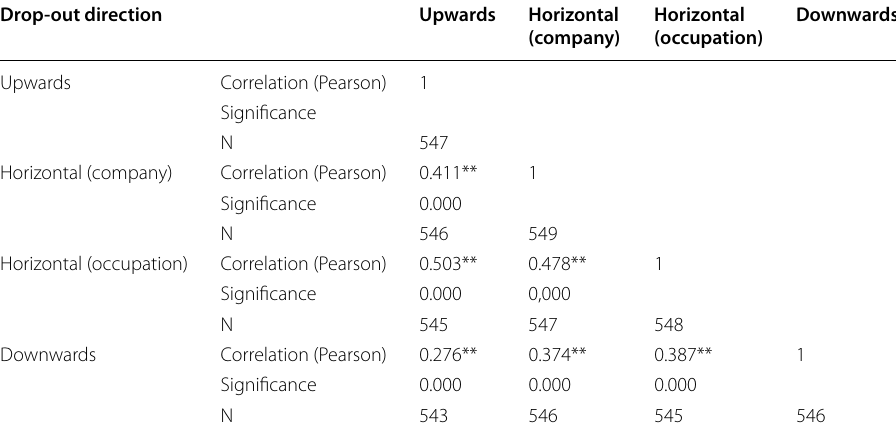
**Correlation is significant at 0.01 (two‑sided) *Correlation is significant at 0.05 (two‑sided)